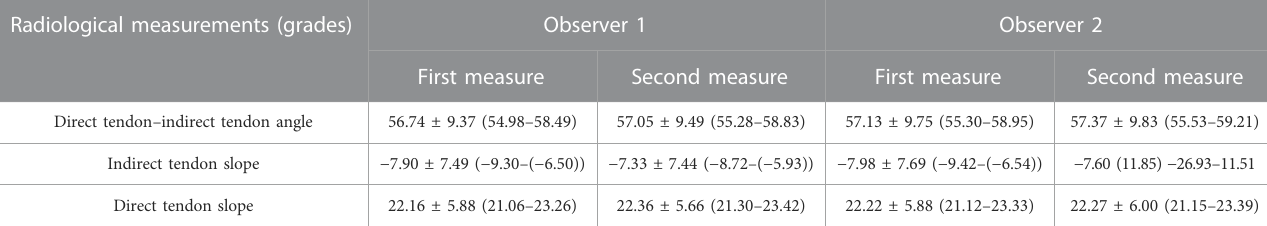
TABLE 2 Descriptions of radiological measurements of DT-IT angle, IT slope, and DT slope for observer 1 and observer 2. Radiological measurements